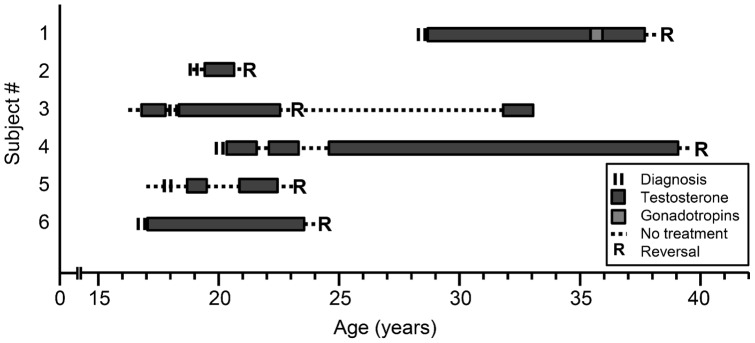
Schematic depicting time of diagnosis, treatment history, and reversal in 6 men with congenital hypogonadotropic hypogonadism.